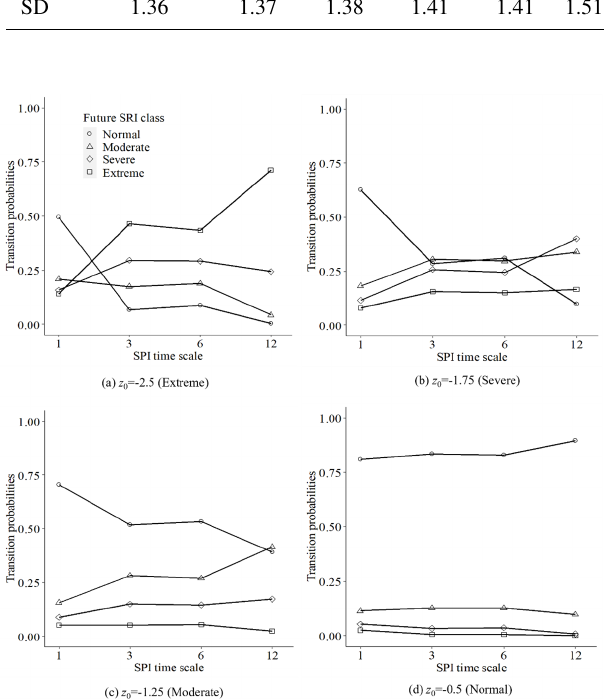
Figure 3. Influence of the SPI timescale on transition probabilities ( z 0 : initial value of SPI).